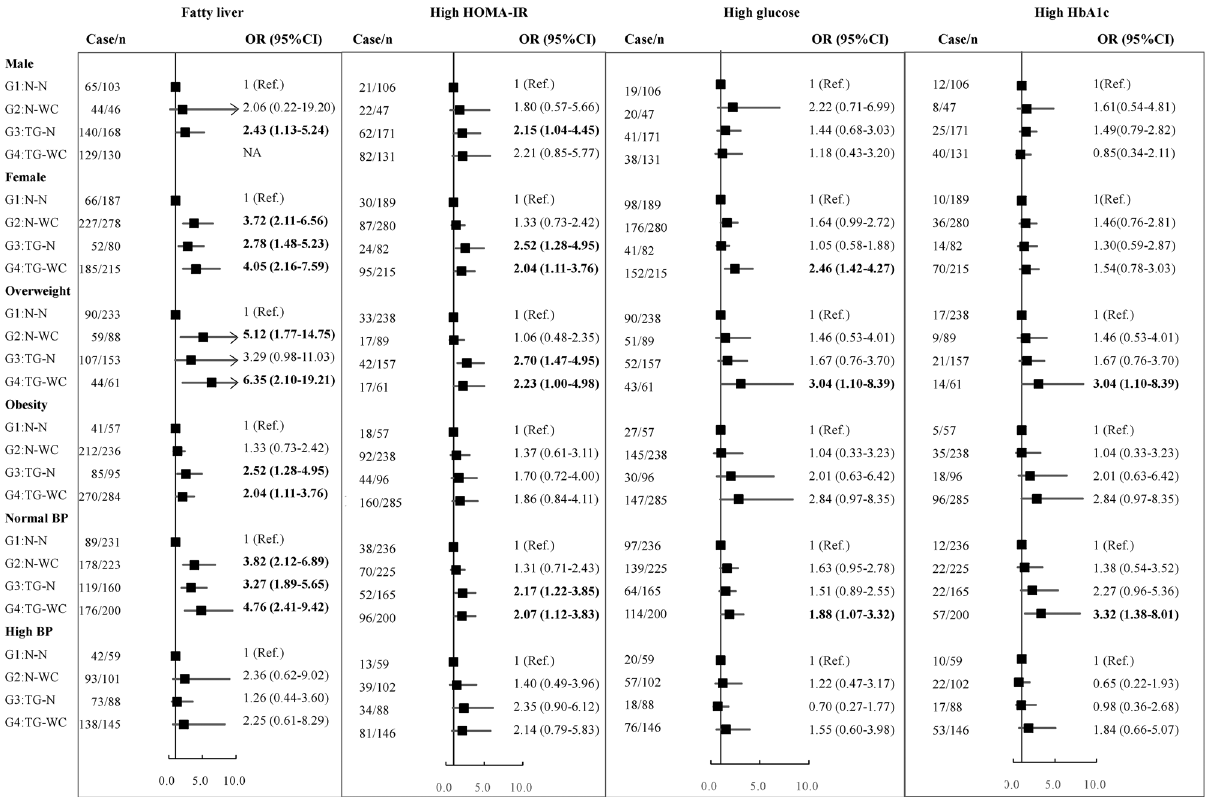
Figure 1. Subgroup analysis of the association between hypertriglyceridemic waist phenotype and fatty liver and glycometabolic profile. Data expressed as odds ratio (OR) ([95% confidence interval [CI]); All the analyses were adjusted for age, sex, body mass index (BMI), smoke, alcohol, physical activity, and sedentary time; G1, N-N, normal TG & normal WC; G2: N-WC, normal TG & high WC; G3: TG-N, high TG & normal WC; G4: TG-WC, high TG & high WC; HOMA-IR, Homeostatic Model Assessment of Insulin Resistance index; HbA1c, glycosylated hemoglobin; BP, blood pressure; High WC was defined as ≥ 102.0 cm for males and ≥ 88.0 cm for females, high TG as ≥ 1.71 mmol/L, high HOMA-IR as ≥ 3.19, high glucose as ≥ 5.6 mmol/L, and high HbA1c as ≥ 6.5%; Overweight was defined as 24.0 ≤ BMI < 28.0 kg/m 2 , obesity as BMI ≥ 28.0 kg/m 2